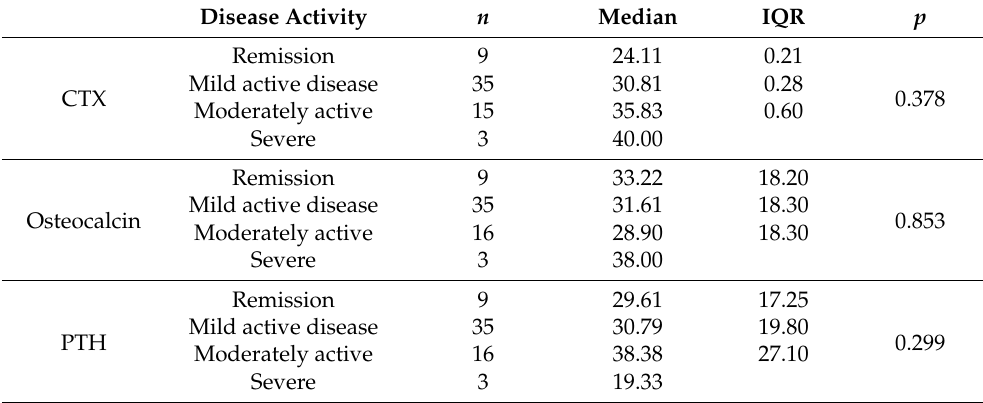
Table 8. Differentiation of CTX, osteocalcin, and PTH depending on disease activity in UC.